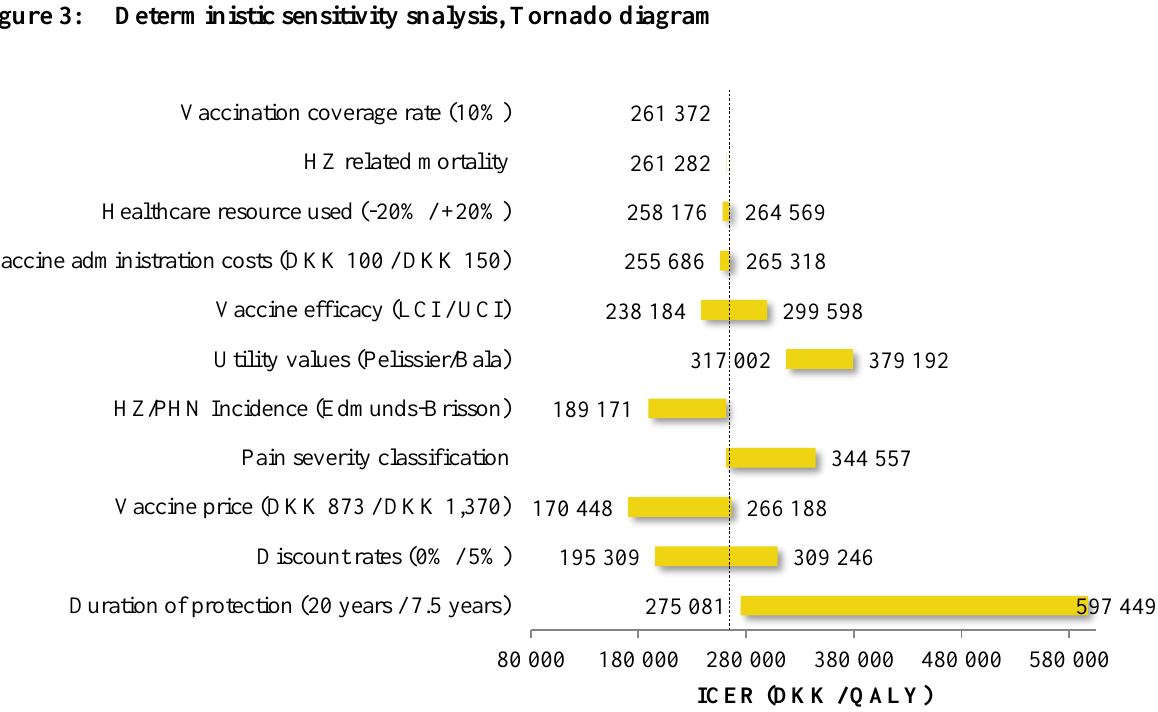
Figure 3: Deterministic sensitivity snalysis, Tornado